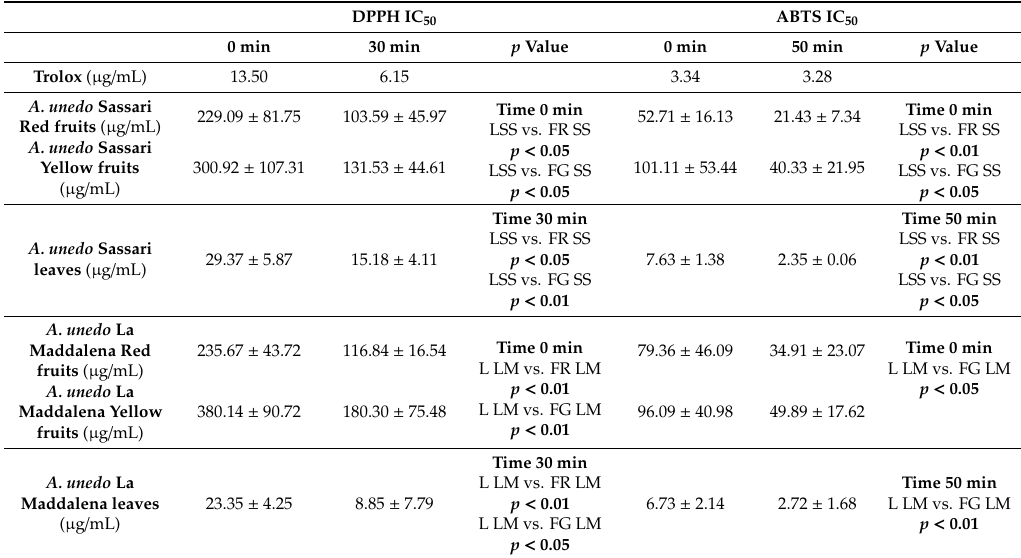
Table 2. Scavenging of 50% of DPPH and ABTS radical by Trolox and ethanolic extracts of Arbutus unedo of di ff erent areas of Sardinia, at di ff erent time